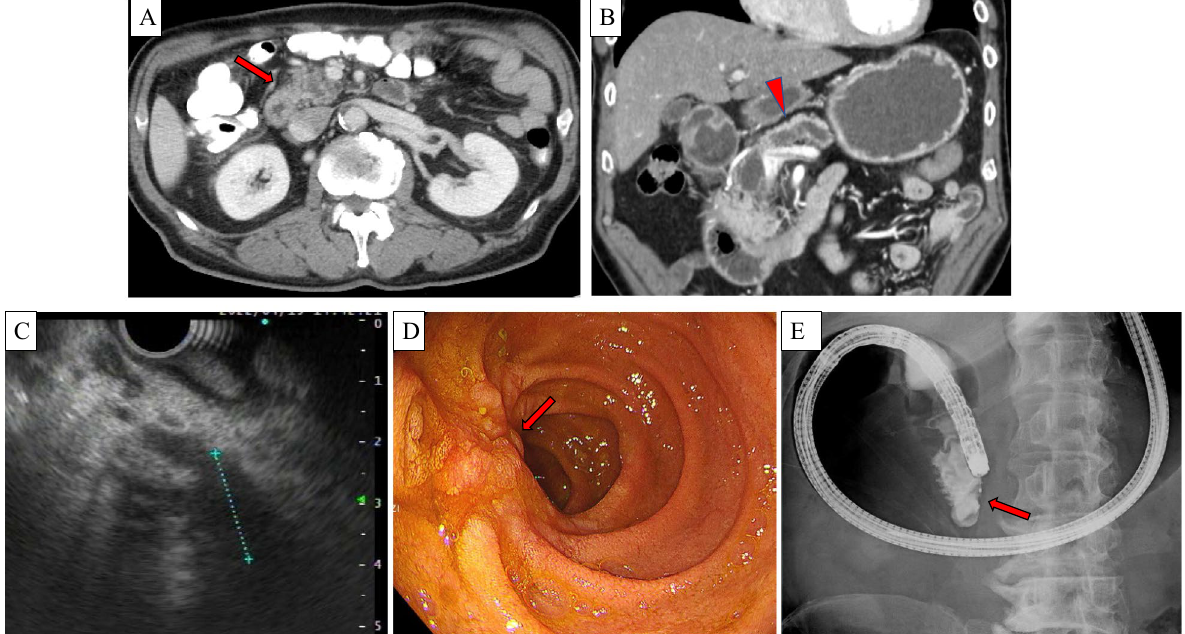
Fig. 1 Enhanced abdominal CT and GI endoscopic findings. Enhanced CT showed stenosis in the third portion of the duodenum in the ( A ) (red arrow) axial view and ( B ) (red arrow) coronal view. Enhanced CT also revealed dilatation of the main pancreatic duct ( B ) (red arrowhead) and atrophy of the pancreatic head. EUS revealed a hypoechoic area at the deep lesion of pancreatic head, approximately 20 mm ( C ). GI endoscopy revealed one-third circumferential mucosal irregularity from the anal side of the main duodenal papilla to the inferior duodenal angulus, which bled easily ( D ) (red arrow). A biopsy was performed from the same site. Severe stenosis was observed from the inferior duodenal angulus to the third portion, and the scope could not pass through ( E ) (red